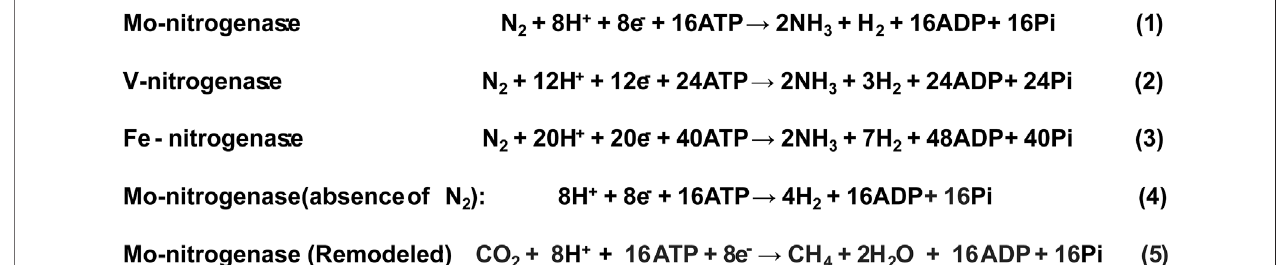
FIGURE 5 | Stoichiometries of production of ammonia, hydrogen and methane through nitrogenase in R. palustris . The references were (McKinlay and Harwood, 2010b; Yang et al., 2012; Fixen et al., 2016; Harwood, 2020).